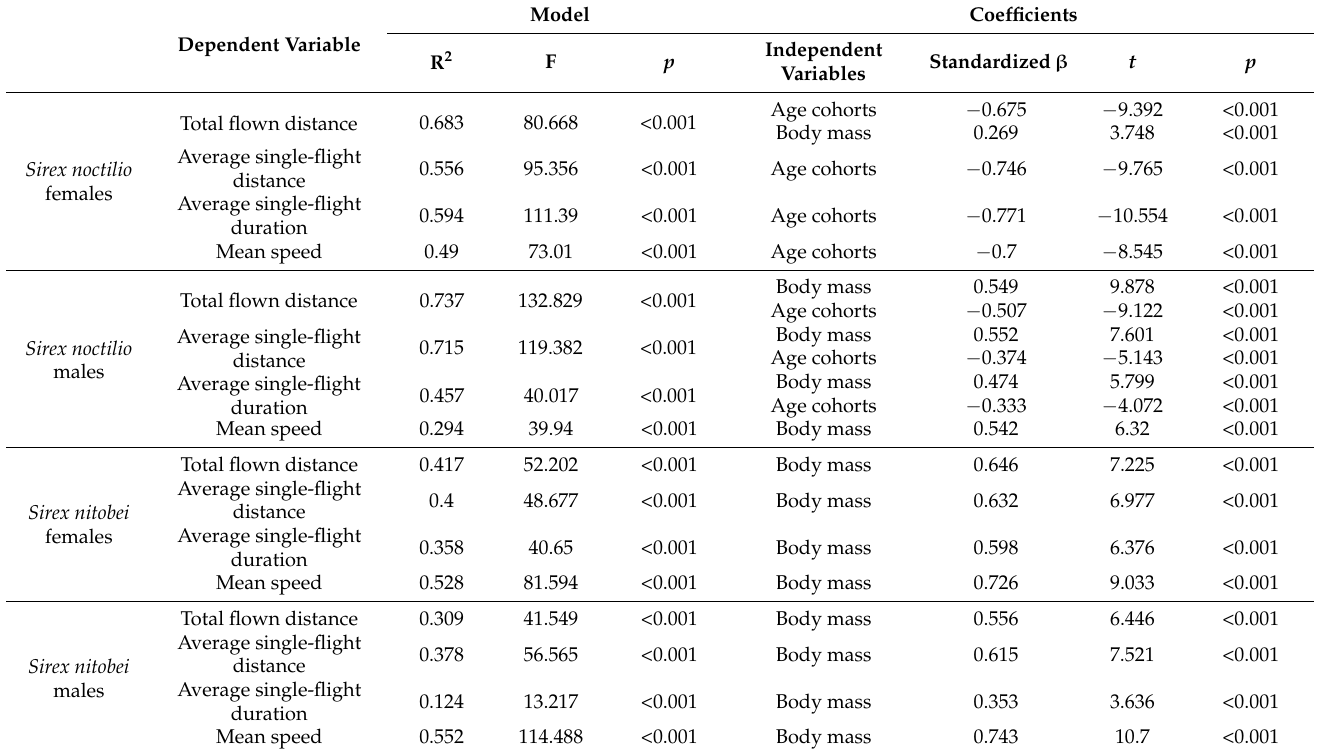
Table 1. Interpretation model of flight performance parameters and independent variables in Sirex noctilio and Sirex nitobei